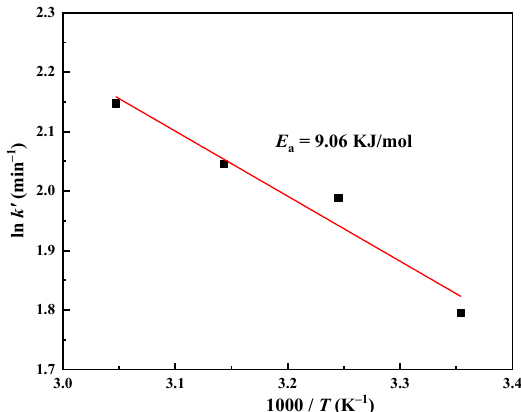
Figure 9. The relationship between ln k ′ and 1000/ T .